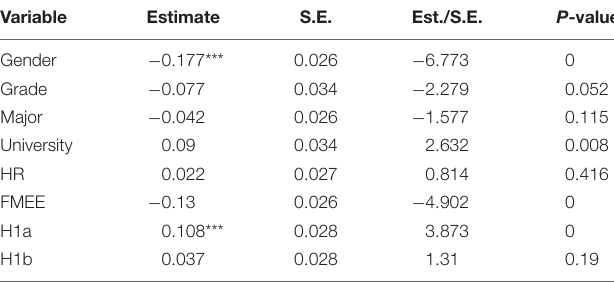
TABLE 3 | Direct effect